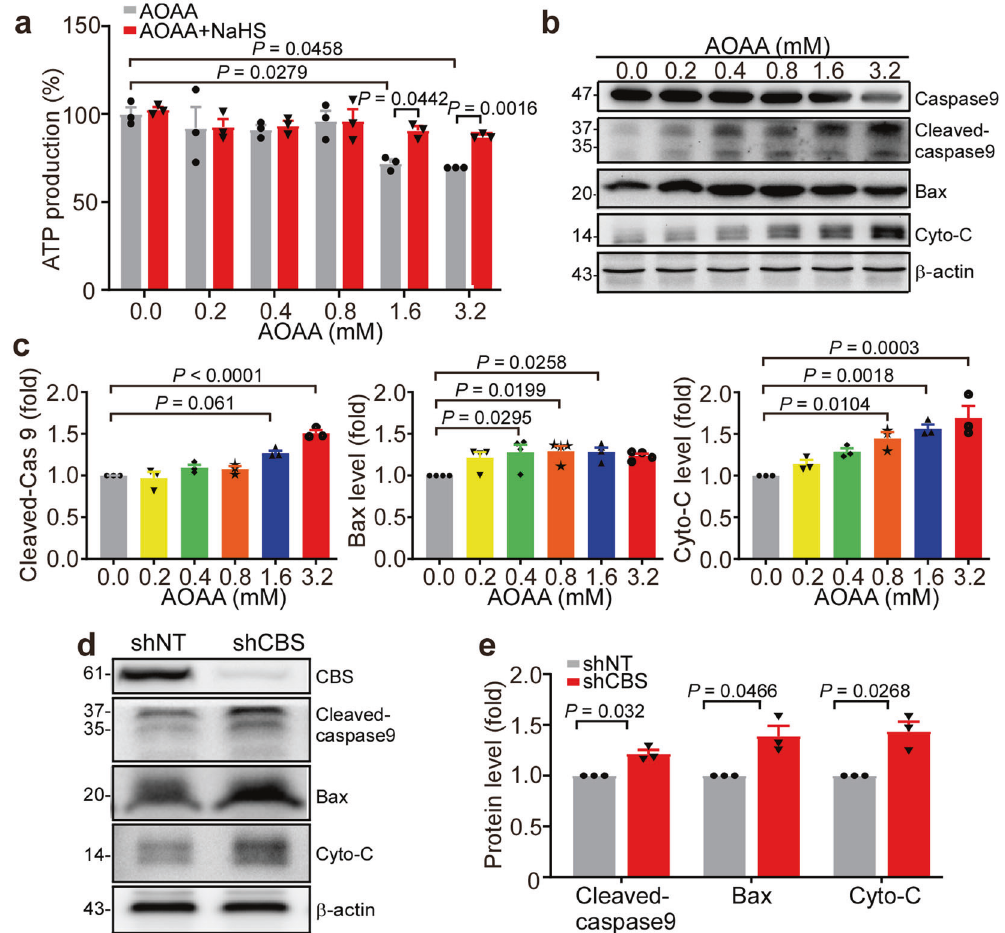
groups are normalized with the non-intervention group (AOAA 0.0 mM). b , c K562 cells were treated with AOAA (0.0, 0.2, 0.4, 0.8, 1.6, and 3.2 mM) for 48 h. Western blot analysis was performed to detect the expressions of caspase 9/cleaved caspase-9, Bax and the cytosolic Cyto